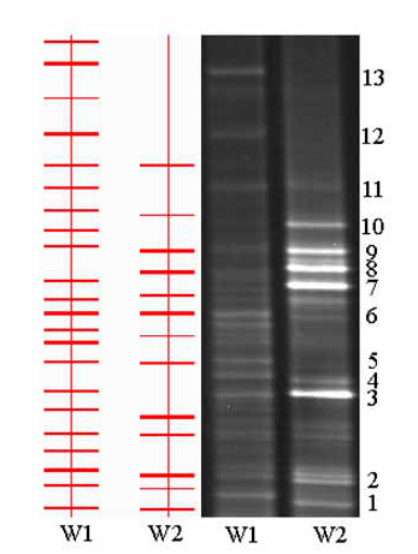
Fig. 5. DGGE fingerprint of 16Sr DNA fragments (right) and lanes comparison (left). W1-real domestic wastewater; W2- synthetic domestic wastewater